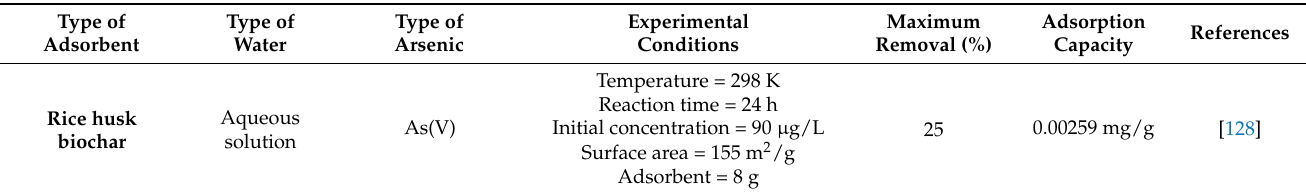
Table 10. Adsorption capacities of arsenic by rice